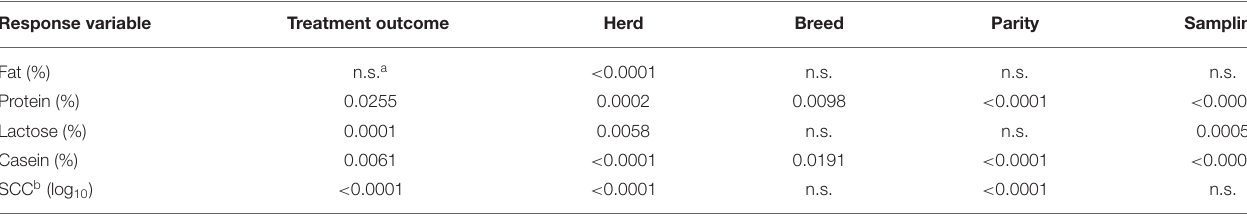
TABLE 6 | Significance of fixed effects on milk components and SCC resulting from ANOVA analysis.